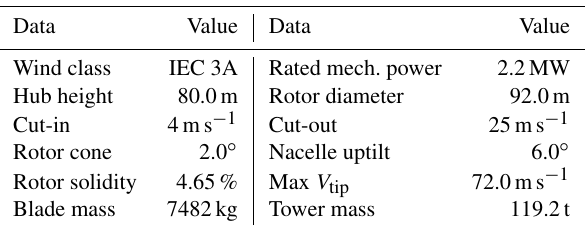
Table 3. Extent of the structural components and their materials for the 2.2MW wind